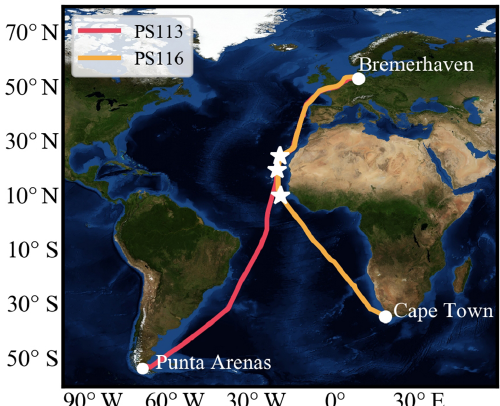
Figure 1. Ship tracks for RV Polarstern cruises PS113 and PS116. PS113 started from Punta Arenas, Chile, on 7 May 2018 and arrived at Bremerhaven, Germany, on 11 June 2018. PS116 started from Bremerhaven, Germany, on 11 December 2018 and arrived at Cape Town, South Africa, on 11 December 2018. White stars mark the location of the case studies presented in Sect.